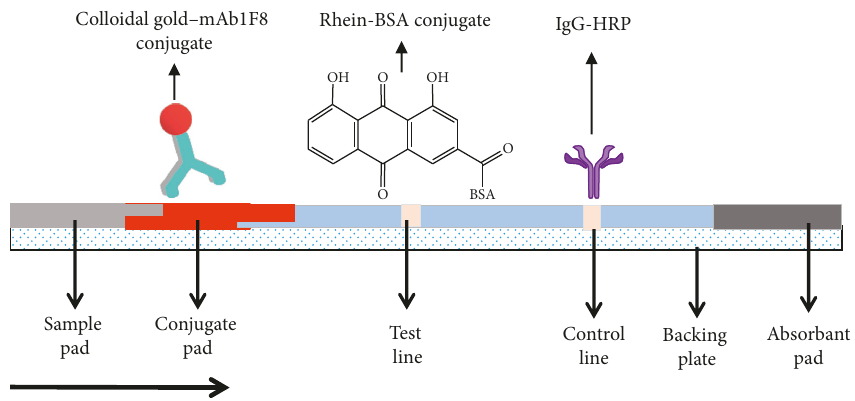
Figure 2: Assembly of CGIC